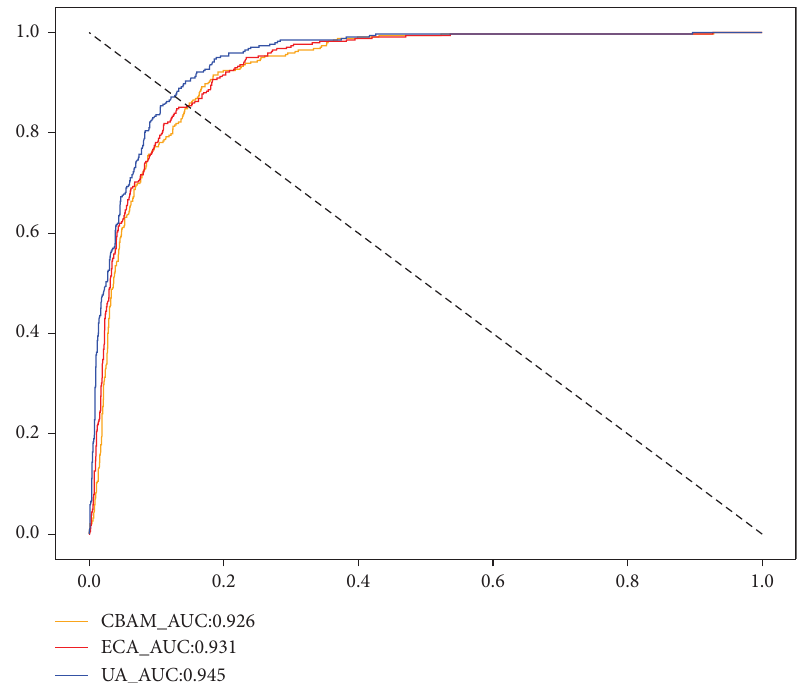
Figure 13: Prediction method results in diferent attention